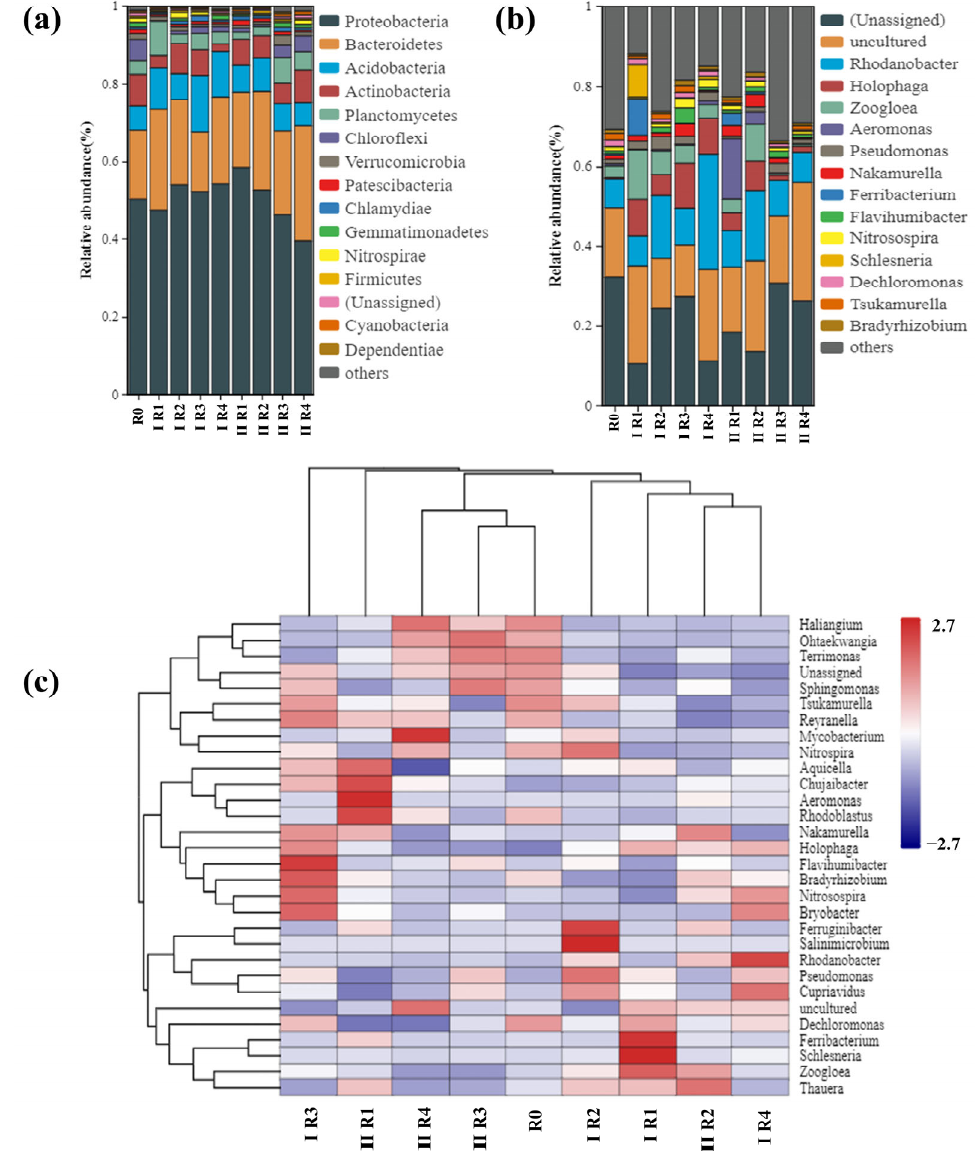
Figure 4. Microorganism community distribution at the ( a ) phylum level and ( b ) genus level in different BRC‑MFCs. ( c ) Clustering heat map of abundance at the genus levels with the 30 highest abundance levels in different BRC‑MFCs.3.2.2. Response of Functional Genes for Denitrification under Combined TC and OFLX